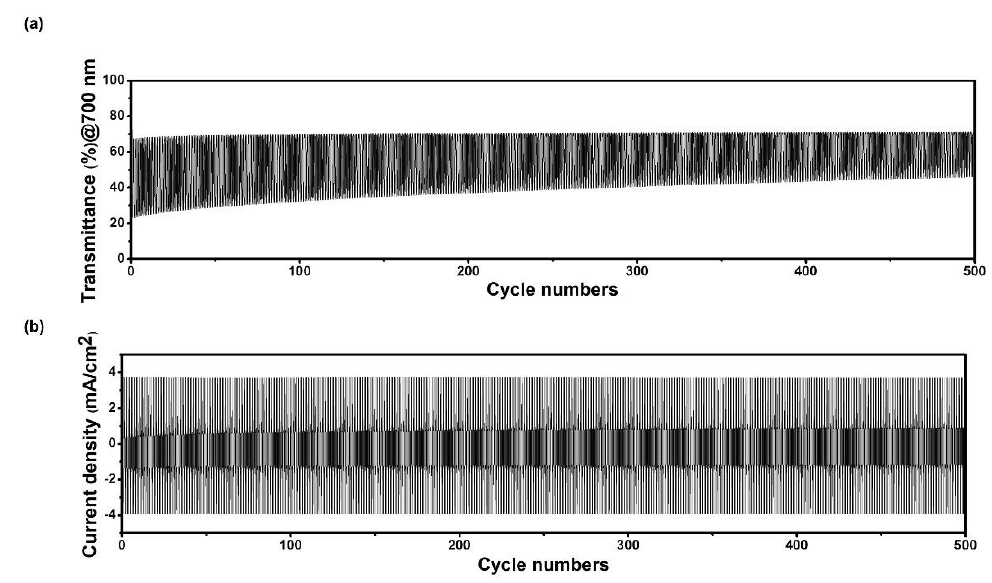
Figure 5. The cycle stability test for the ECD containing a porous film of WO 3 @PEO fibers with WO 3 :PEO = 1:1. ( a ) transmittance-cycle and ( b ) current density-cycle plots. A voltage was applied during the cycling test, and it was − 2 V for the colored state and 1 V for the bleached state. Each voltage was applied for 10 s.